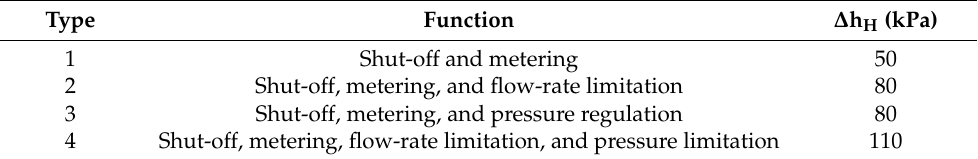
Figure 4. Identification marking of multioutlet hydrants in field. *PN6 in bar (600 kPa).